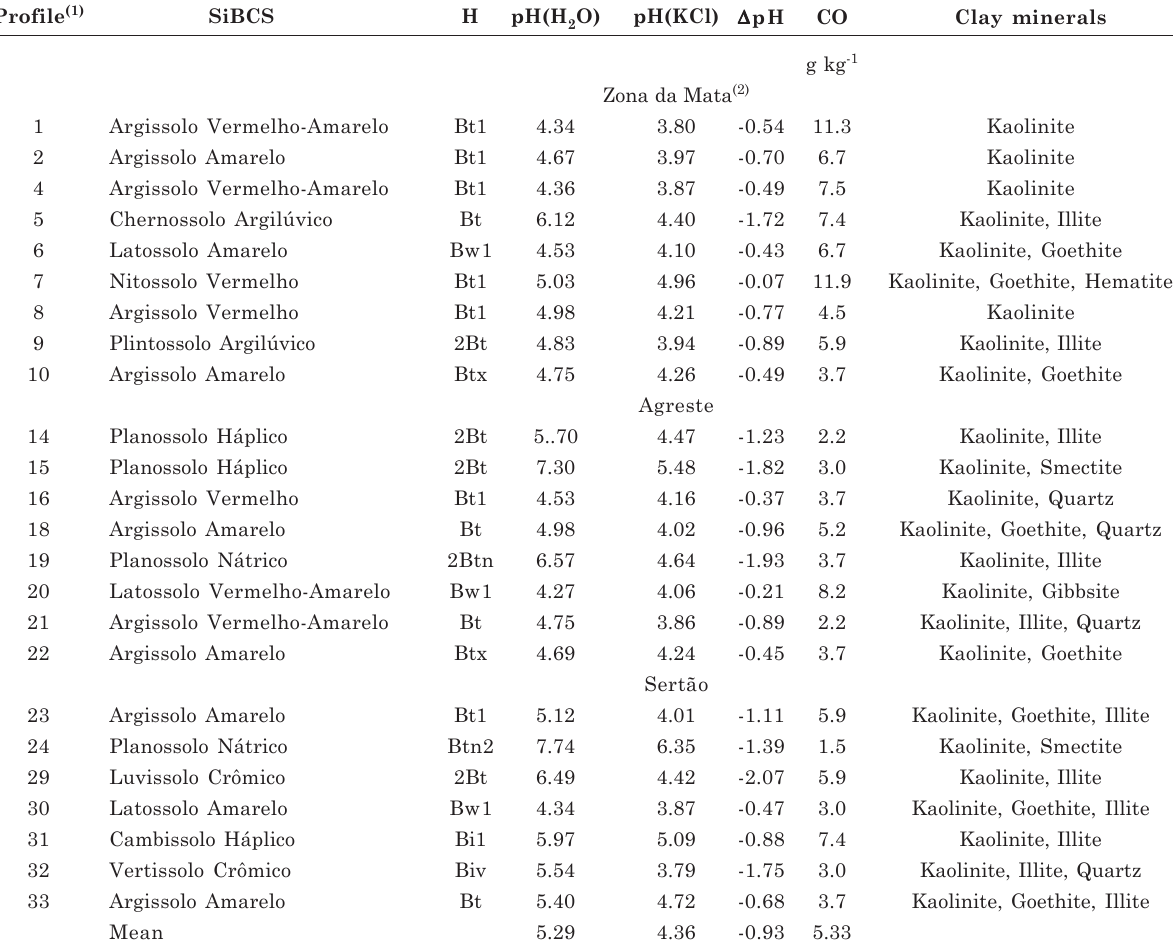
Table 2. pH (H 2 O and KCl), ∆∆∆∆∆ pH, organic carbon (OC) and principal clay minerals of the sampled horizons (H) of reference soils of the State of